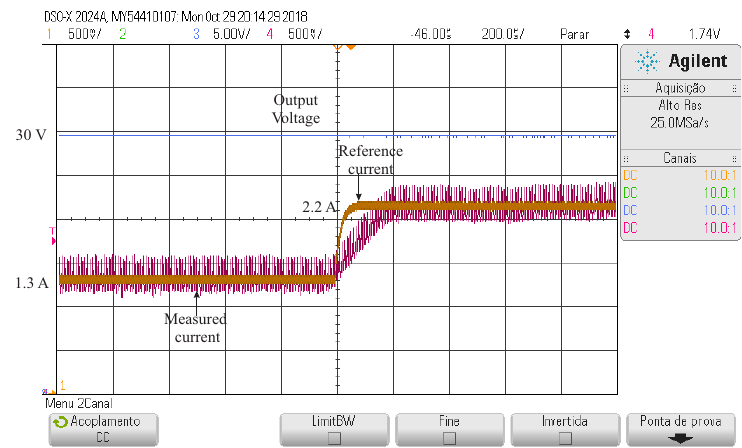
Figure 7. Response of the sliding mode plus proportional-integral (SMPI) for a current step test.